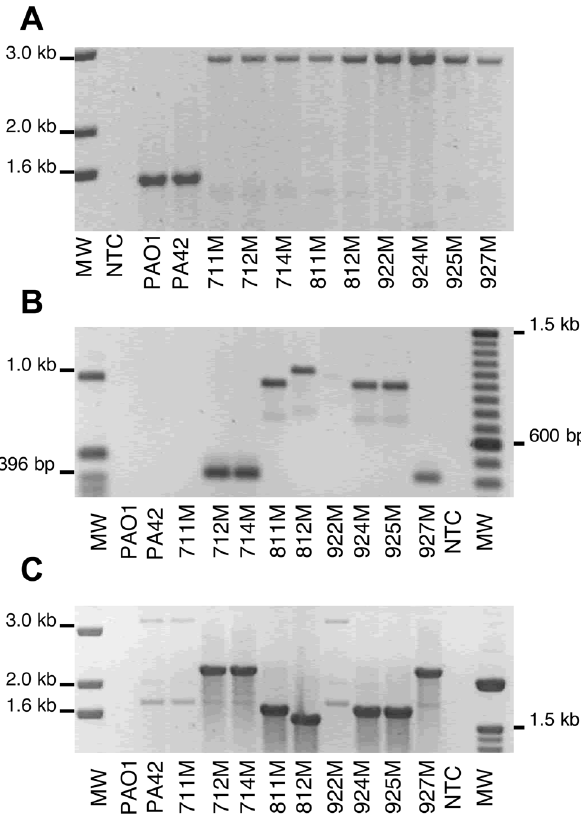
Figure 1. PCR amplification of oprD and IS Pa 8 from carbape- nem-resistant mutants of P.aeruginosa . (A) Primers that flanked the oprD gene were used to PCR-amplify the oprD gene giving an expected PCR product size is 1586 bp. Each lane is labeled with its respective DNA ladder (1 kb DNA ladder, Invitrogen), no template control (NTC), or P. aeruginosa isolate. (B) PCR amplification of IS Pa 8 within the oprD